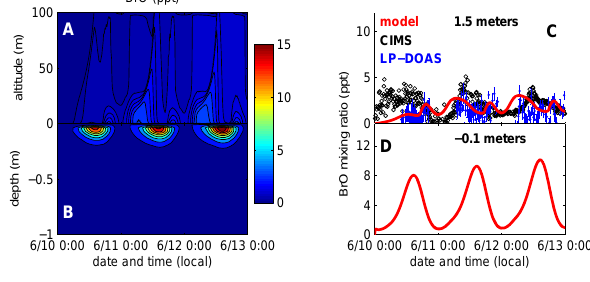
Fig. 7. Modeled BrO mixing ratios in the atmosphere (A) and in- terstitial (B) air. Modeled mixing ratios in tha atmosphere at an al- titude of 1.5m above the snowpack are compared with both CIMS and LP-DOAS measurements in panel (C) . Predicted interstitial air mixing ratios 10cm below the snow surface are shown in (D)